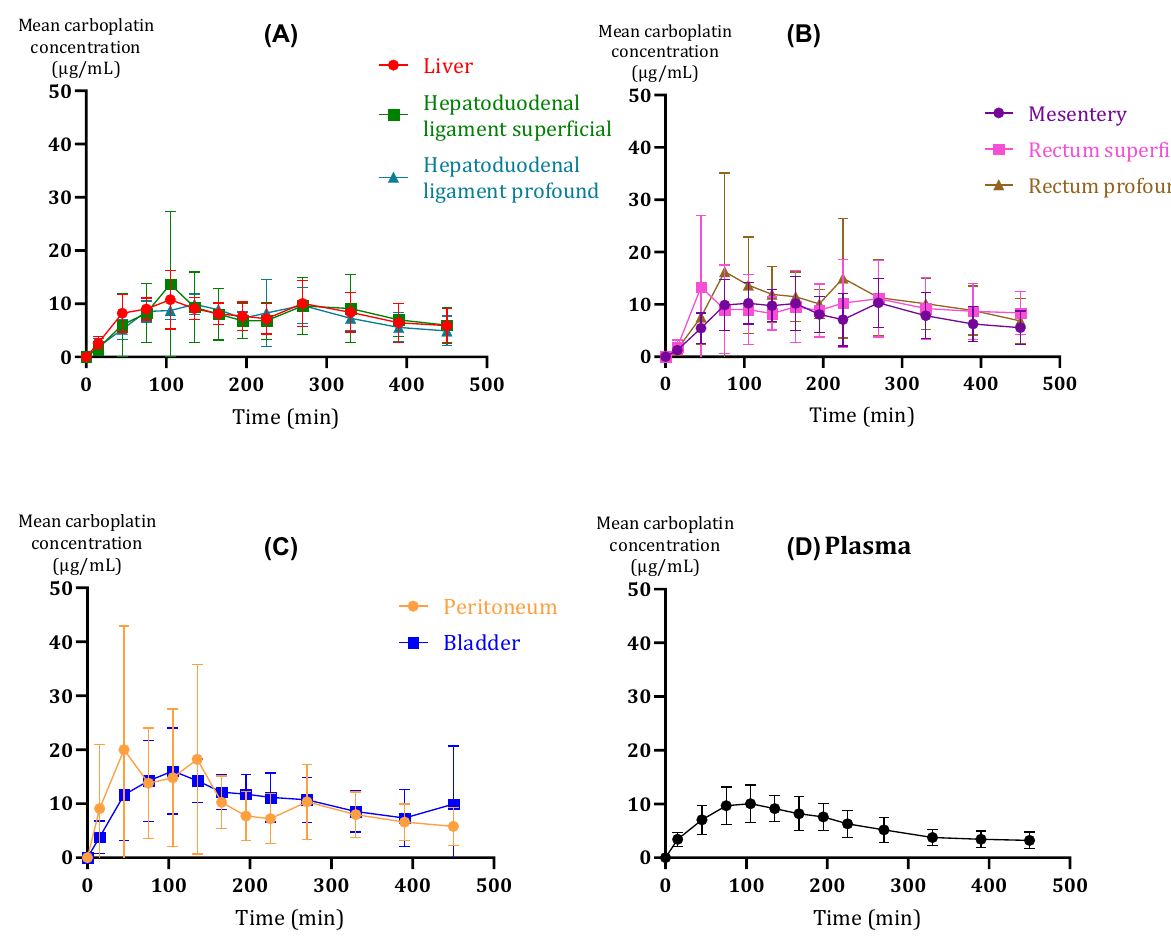
Figure 3: Mean concentration-time profiles with subdivision of compartments by anatomical regions. (A)liver,profoundandsuper fi cialhepatoduodenalligament(HL),(B)mesentery,rectumprofoundandsuper fi cial,(C)peritoneumandbladder wall, and (D) plasma. The bars represent 95% con fi dence